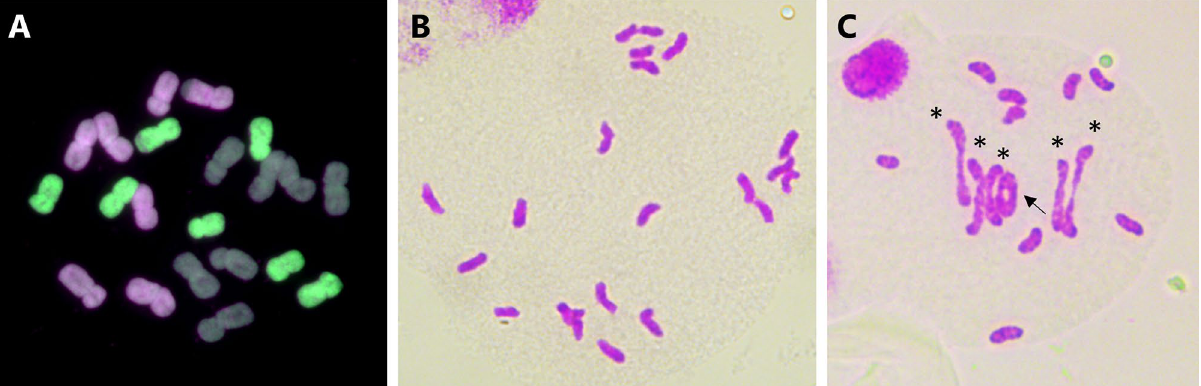
Figure 5. Partial loss-of-function TaZIP4-B2 mutation ( zip4-ph1d ) allows CO formation between homoeologous chromosomes in haploid wheat. ( A ) Root-tip metaphase of one representative of the haploids (n = 3x = 21) labelled by genomic in situ hybridisation (GISH). Seven A-genome chromosomes are shown in magenta, seven B-genome chromosomes in grey and seven D-genome chromosomes are shown in green. ( B,C ) Representative meiotic metaphase I configurations of haploid Cadenza WT ( B ) and haploid zip4-ph1d ( C ) stained by Feulgen. Haploid Cadenza WT shows no chiasma while haploid zip4-ph1d displays five rod bivalents (indicated by an asterisk) and one ring bivalent (indicated by an arrow).